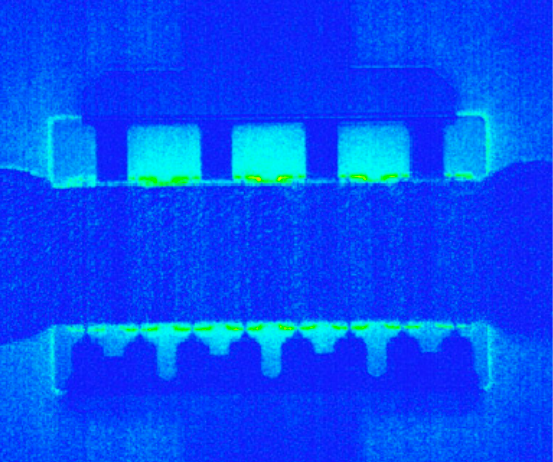
Figure 17. Thermoreflectance measurements of the device temperature.